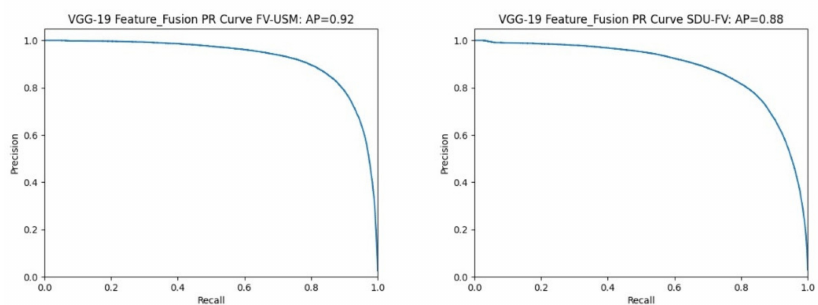
Figure 10. Fusion of identified P-R curves on the VGG-19 feature extraction network.